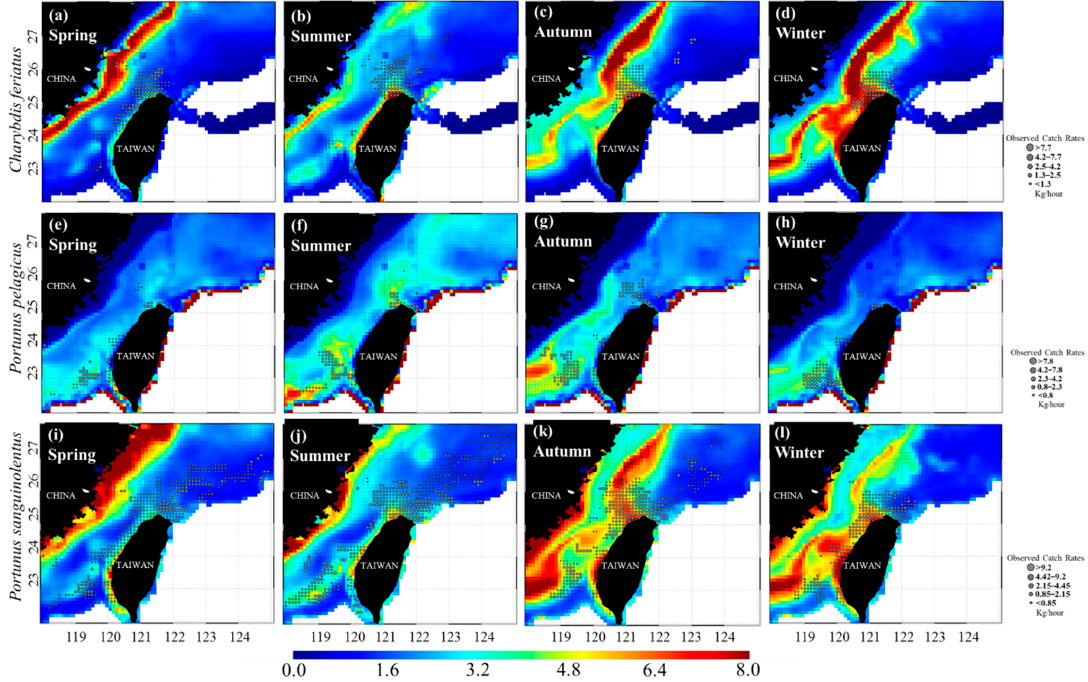
Figure 6. Seasonal mean of observed catch rates of C. feriatus ( a)–(d ), P. pelagicus ( e)–(h ), and P. sanguinolentus ( i)–(l ) overlaid with catch rates predicted by selected generalized additive models (GAMs) in 2011–2015. Table 2. Numbers (>60%) of observed (O) and predicted (P) high catch rates of C. feriatus , P. pelagicus, and P. sanguinolentus in the TS in 2016. The RMSE represented the test error metric of cumulative frequency